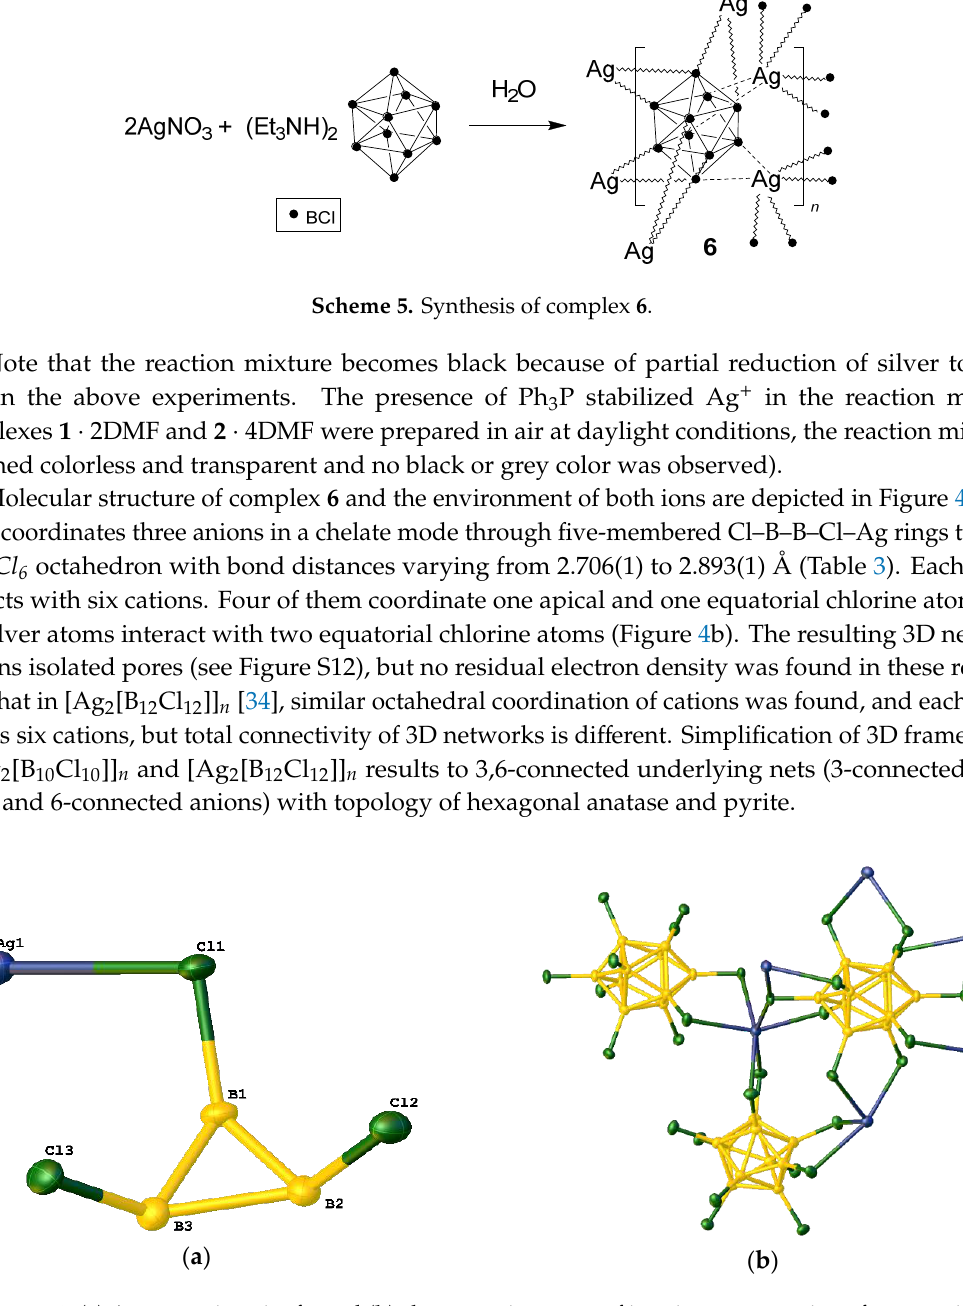
Figure 4. (a) Asymmetric unit of 6 and ( b ) closest environment of ions in representation of atoms with thermal ellipsoids ( p = 50%). thermal ellipsoids ( p =